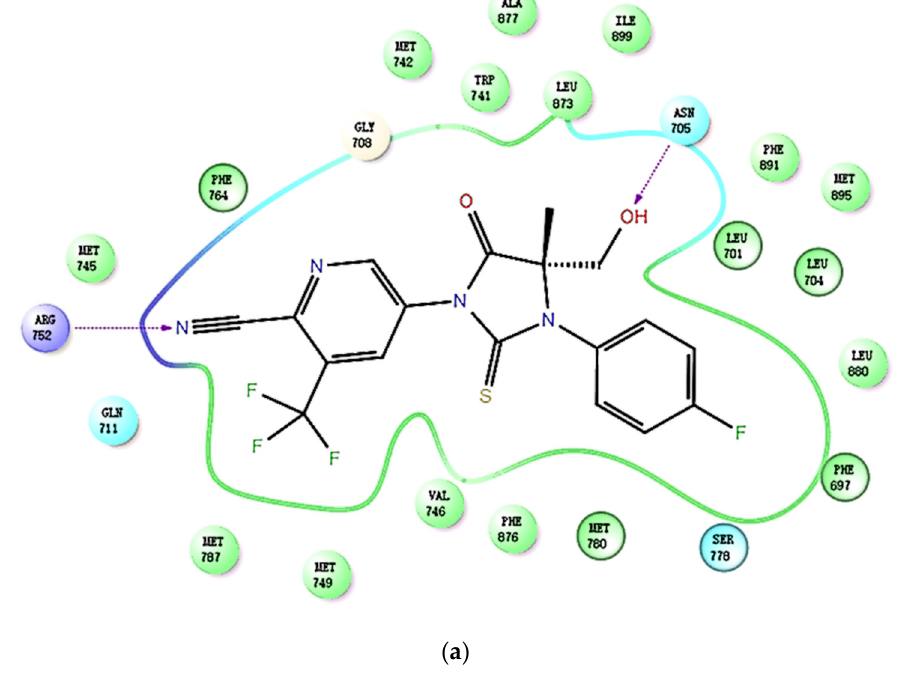
Figure 3a. The cyanyl group of 19b forms an important hydrogen bond with GLY708, Gln711, and TRP741 via a water molecule, similar to enzalutamide and apalutamide (Figure 3b,c). There is a π – π interaction between the pyridine ring and Phe764, which is similar to apalutamide (Figure 3b). Enzalutamide and apalutamide can form a hydrogen bond with ARG779 due to the presence of an acyl group. Obviously, the absence of an acyl group in 19b hinders the formation of this hydrogen bond. However, the extra hydroxyl group in 19b can form a hydrogen bond with ASN705 in the AR, which may be the reason for the high potency of 19b toward AR.